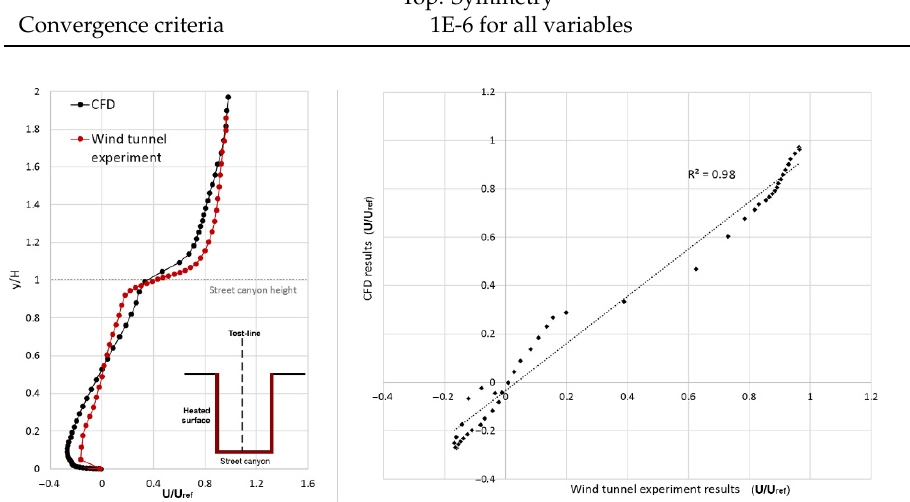
Figure 5. Validation results [22]